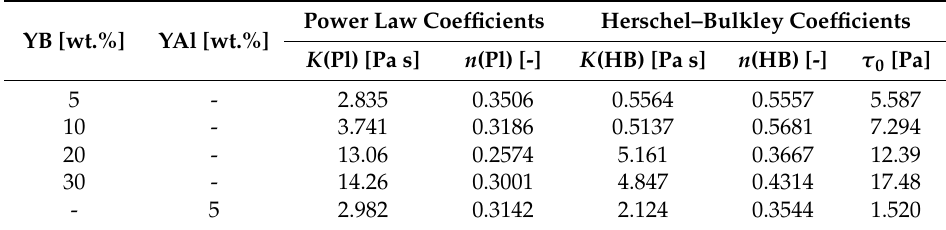
Table 1. Viscosity law coefficients of